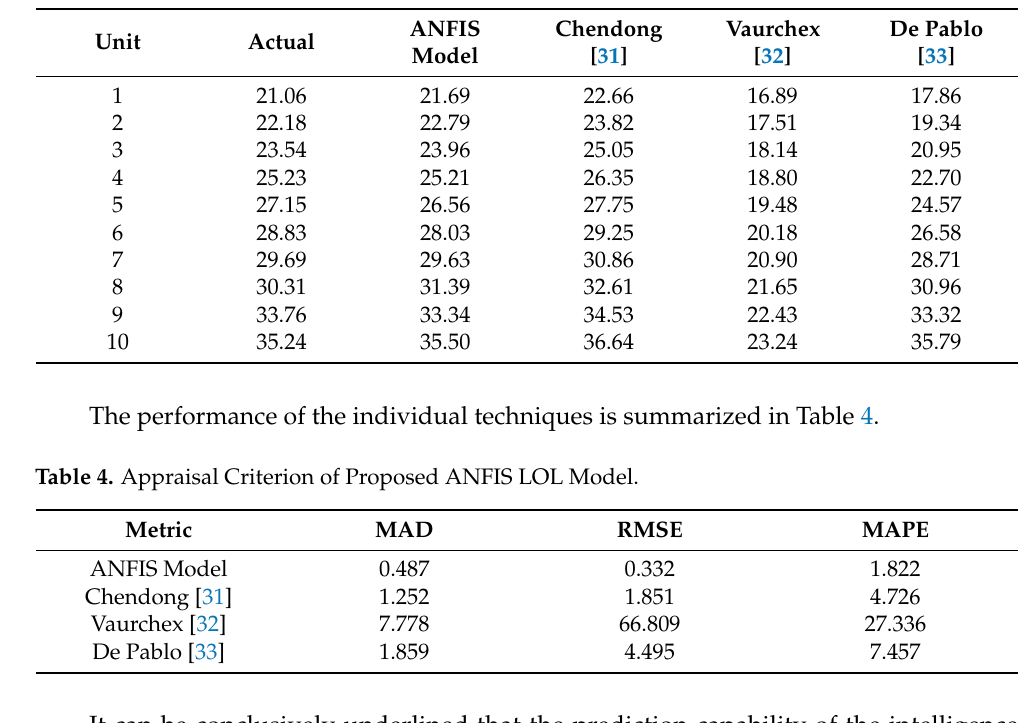
Table 3. Predicted Loss of Life (in years).